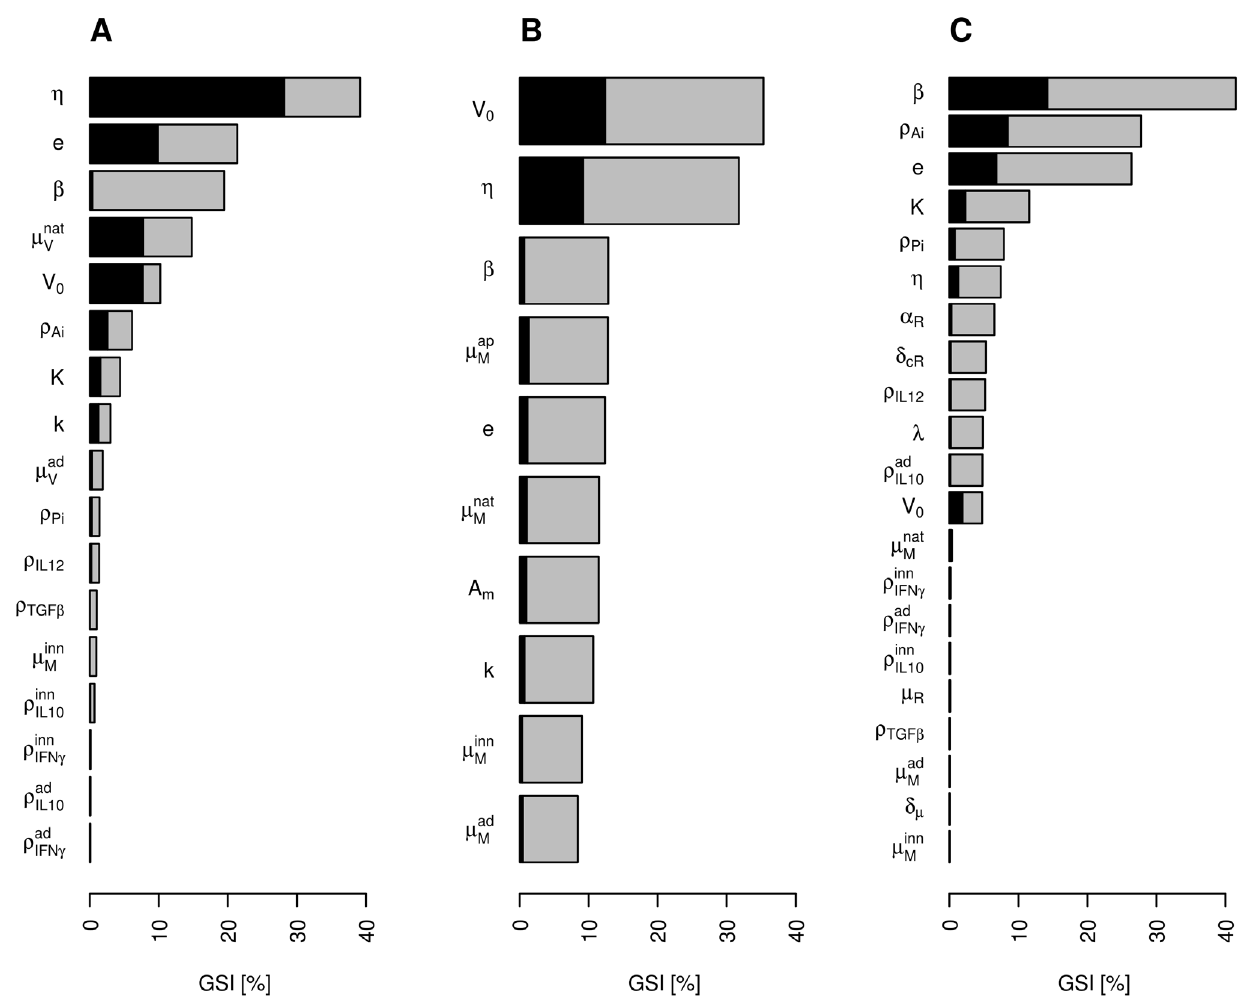
Figure 4. Generalised sensitivity indices (GSI) for the three outputs of interest. A : Viral titer V ( R 2 ~ 0 : 93 ). B : Cumulative number of phagocyting macrophages cM P ( R 2 ~ 0 : 92 ). C : Percentage of infected macrophages among all macrophages % M I ( R 2 ~ 0 : 96 ). Total GSI (bars) are represented for an output-dependent selection of influential parameters. For each parameter, the total GSI is split into main parameter effect (black bar) and the sum of two-parameter interactions involving the parameter (grey bar). R 2 corresponds to the fraction of output variance explained by the parameters. NB: As the two-parameter interactions are counted for both parameters, the sum of the total GSI is higher than 100%.